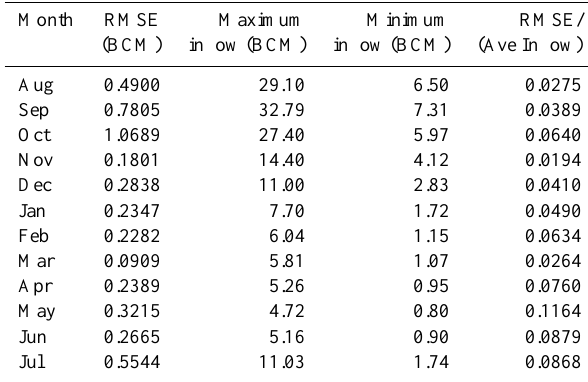
Table 2. RMSE associated with NN forecasting model for each